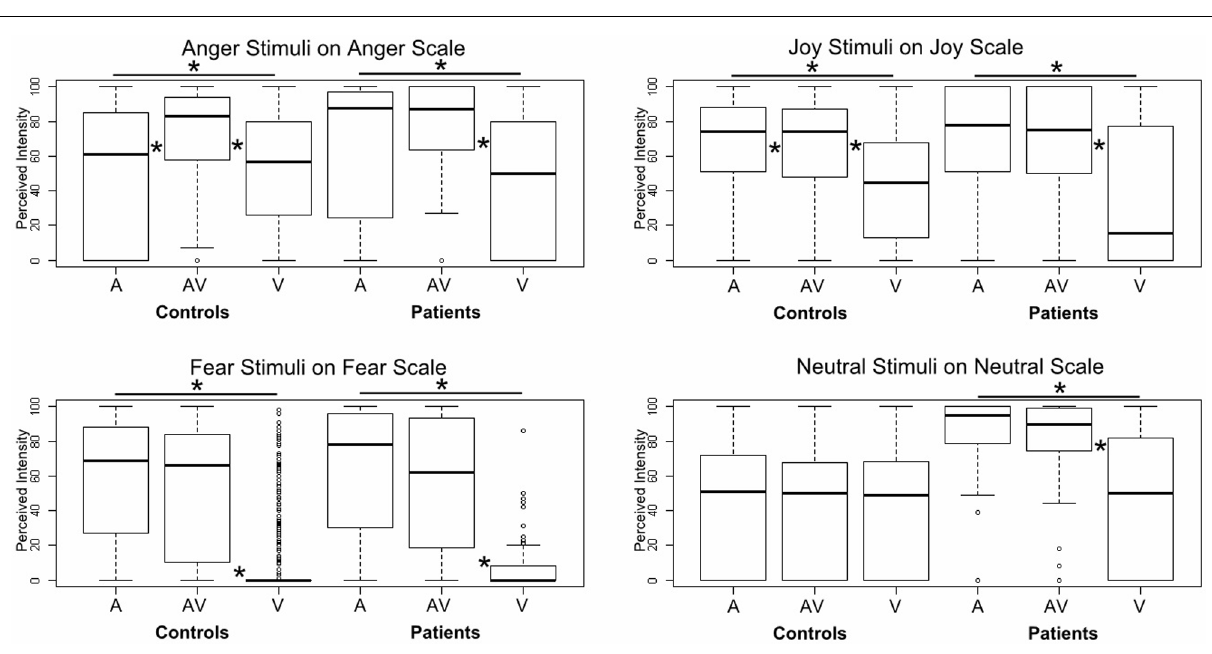
FIGURE 3 | Boxplot of GLM results for intensity ratings of each emotion on the corresponding target scale. Each box corresponds to a specific modality (A: auditory, AV: audiovisual,V: visual) and a specific group (patients